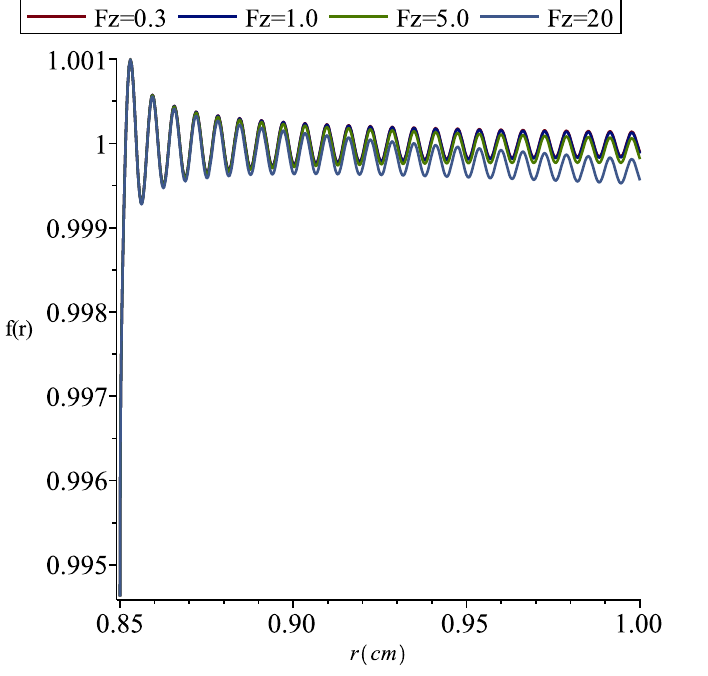
Figure 6. f versus r for α = − 1,000,000 in level set function φ , R i = 0.85 cm is the radial value at the gas/liquid